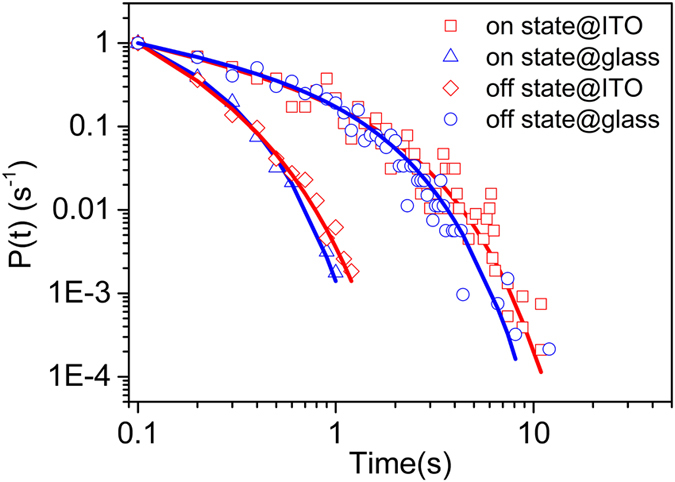
Normalized probability density of on-states (Pon(t)) and off-states (Poff(t)) for single QDs on glass coverslips and encased in ITO, respectively.The solid lines are best fits by a truncated power law. Fitting parameters for QDs on glass coverslips: αon = 0.447, αoff = 0.435, 1/μon = 0.163, and 1/μoff = 1.175; fitting parameters for QDs encased in ITO: αon = 0.529, αoff = 0.965, 1/μon = 1.639, and 1/μoff = 0.264.